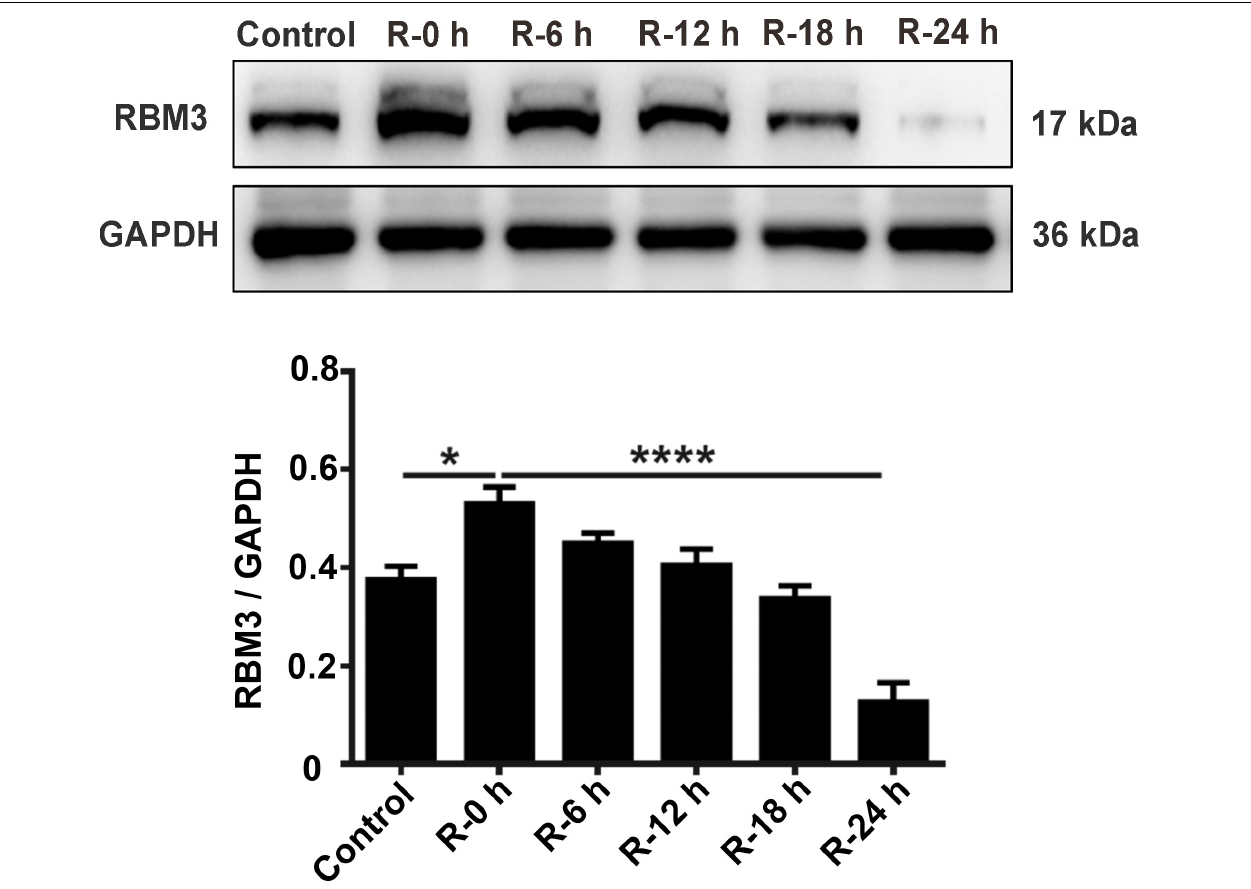
FIGURE 4 | Expression levels of RBM3 in PC12 cells under OGD/R stimulation. Total protein was extracted from PC12 cells at different time points of reperfusion (0, 6, 12, 18, and 24 h) after 6 h of OGD stimulation. Western blot analysis was used to detect RBM3 expression. * , compared with R-0 h group; P < 0.05; **** , compared with R-0 h group; P <